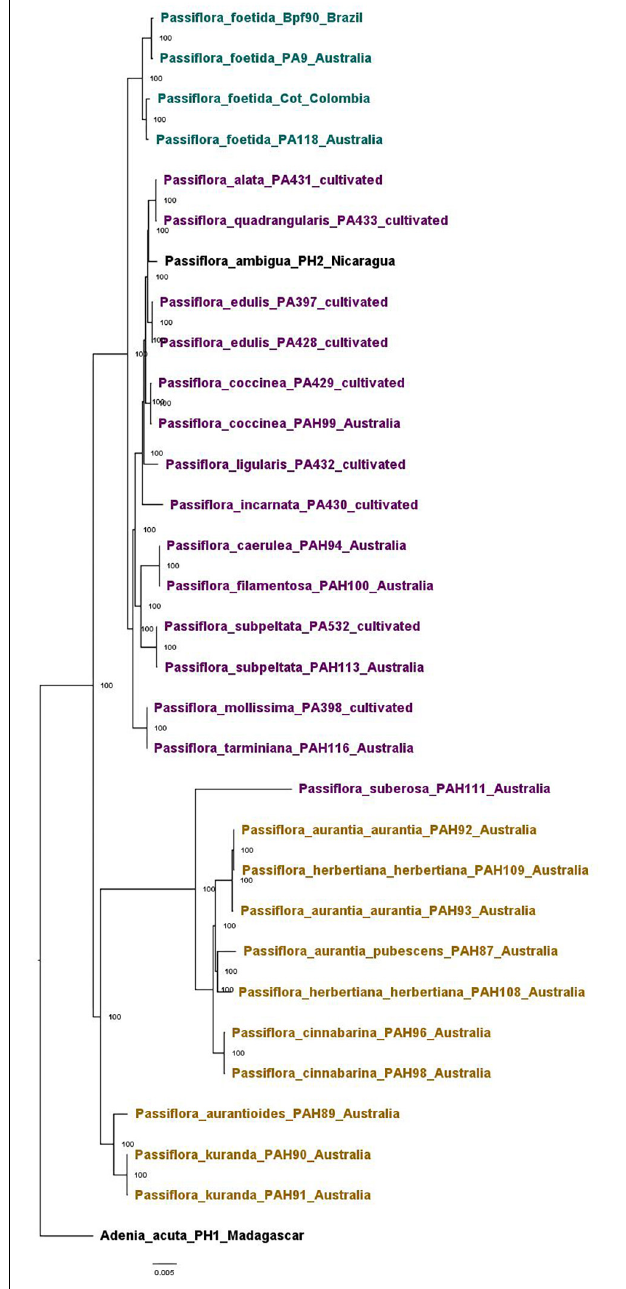
FIGURE 4 | Phylogenetic tree of samples in the Passifloraceae dataset based on the Bayesian analysis, shown with posterior probabilities values. Samples of the native Passiflora species from Australia are colored in khaki, the non-native species in Australia (both cultivated and invasive) in purple, and Passiflora foetida sensu lato in teal. Samples used as outgroups across analyses are in black.